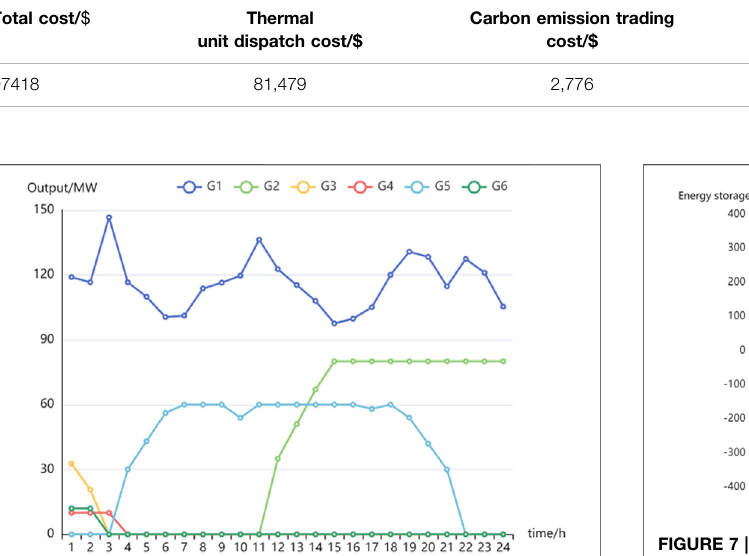
FIGURE 5 | Outputs of thermal units at each period in Scenario 3